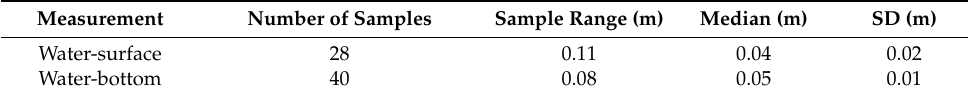
Table 3. GPS post-processing quality-control findings (vertical adjustment).